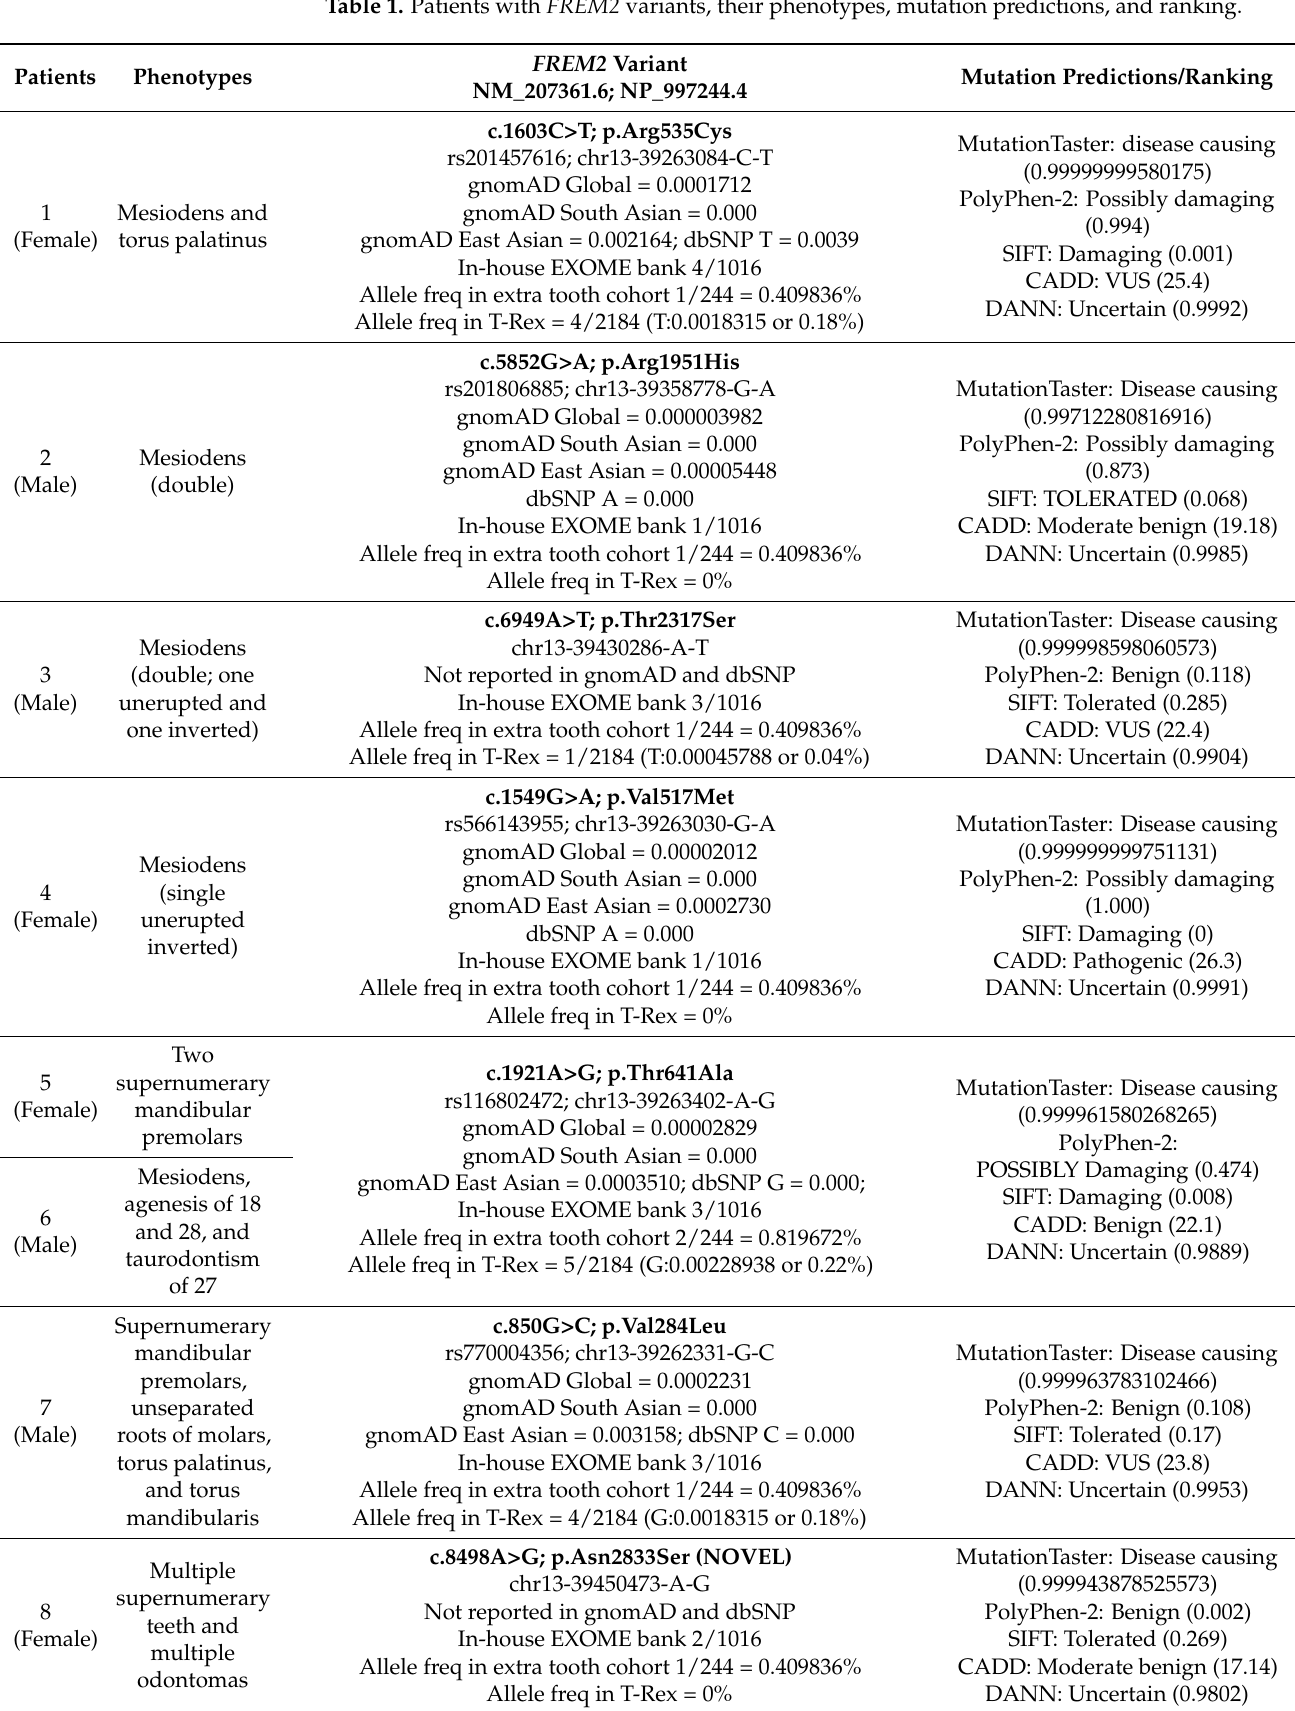
Table 1. Patients with FREM2 variants, their phenotypes, mutation predictions, and